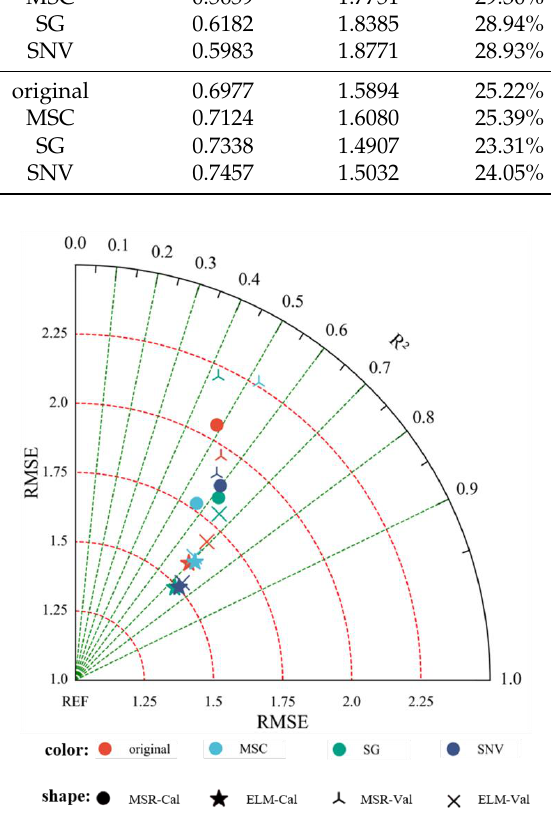
Figure 9. Cotton LAI monitoring model training sets (Cal) and validation sets (Val) result based on vegetation indices: resultant Taylor diagram.